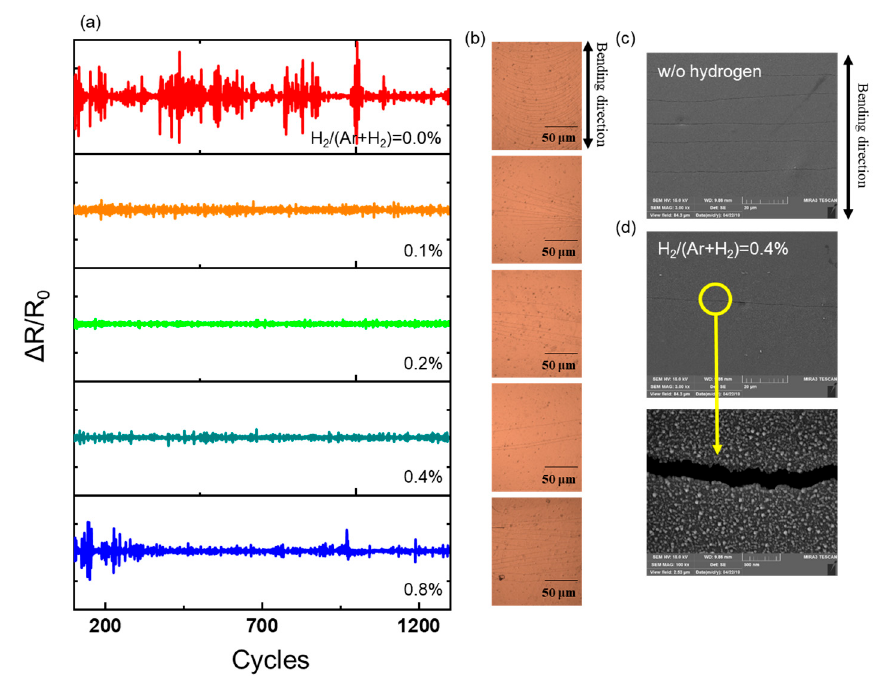
Figure 3. Dynamic bending test results for In − Zn − O thin films prepared with various hydrogen flow rates. ( a ) changes in resistance ( ∆ R / R 0 ) with the bending cycle and ( b ) corresponding surface images after bending tests. ( c ) and ( d ) are surface crack images after dynamic bending of a-IZO thin film deposited without, with hydrogen flow and the enlarged surface crack, respectively.